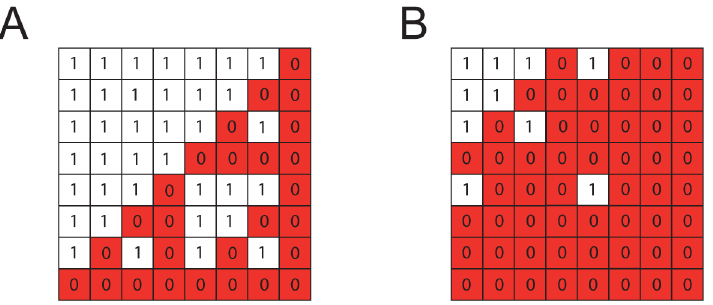
Fig 3. Examples of matrices Z p introduced to calculate the partial background-averaged epistasis for n = 3. (A) Z 2 for when data for mutants up to second-order is available and (B) mutants are available. Both matrices are self-similar, which allows their generation for arbitrary order, and are related to the logic Sierpinski triangle. For example, Z 2 = 1 − A Σ , where A is the anti-diagonal identity matrix and Σ is the Sierpinski matrix (i.e., multigrade AND in Boolean logic) for three